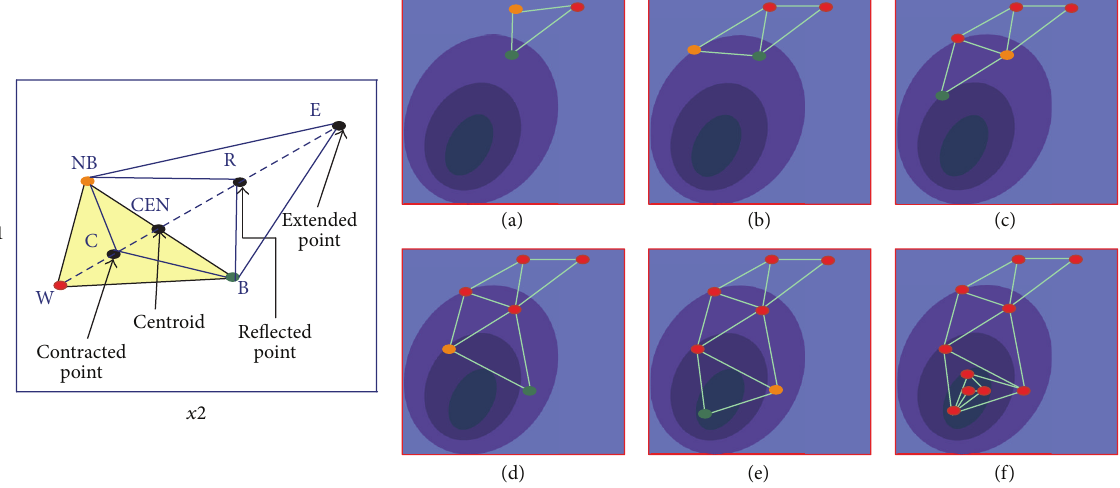
Figure 6: Reflection, expansion, or contraction operations on search area of 2D simplex.